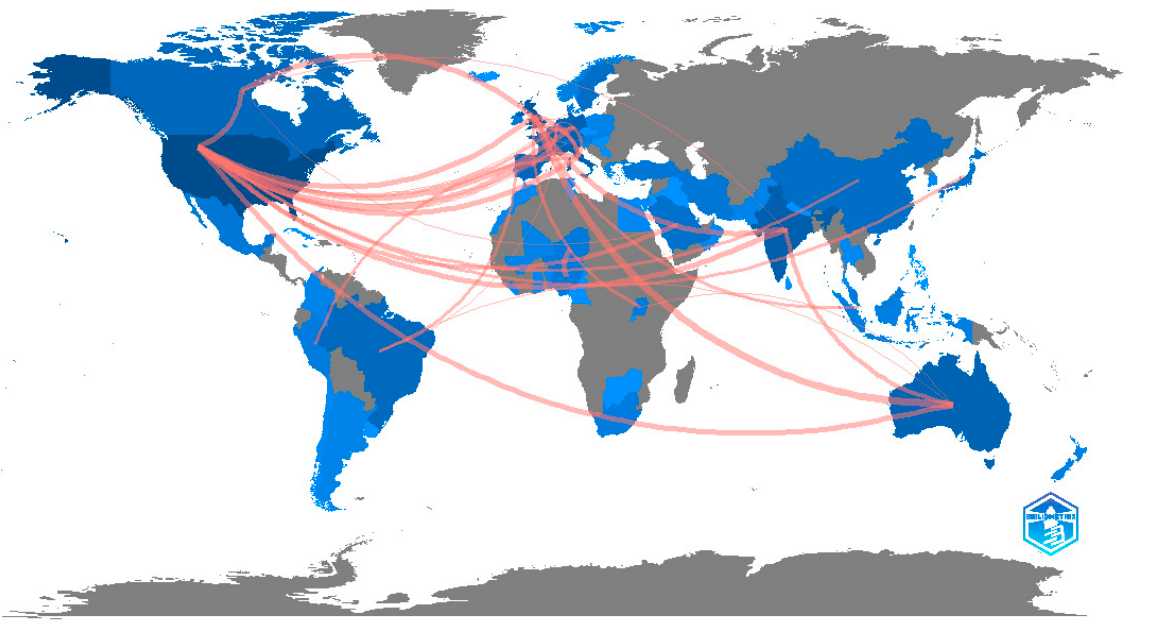
Figure 2. Network visualization map of cooperation between countries using “R”. Darker blue colors represent the most commonly collaborative countries regarding this topic, in terms of the frequency of their publications.